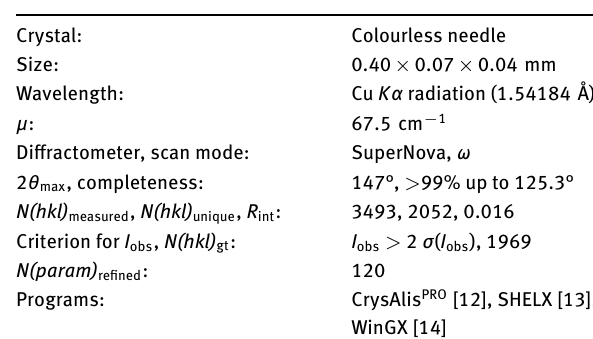
Table 1: Data collection and handling.